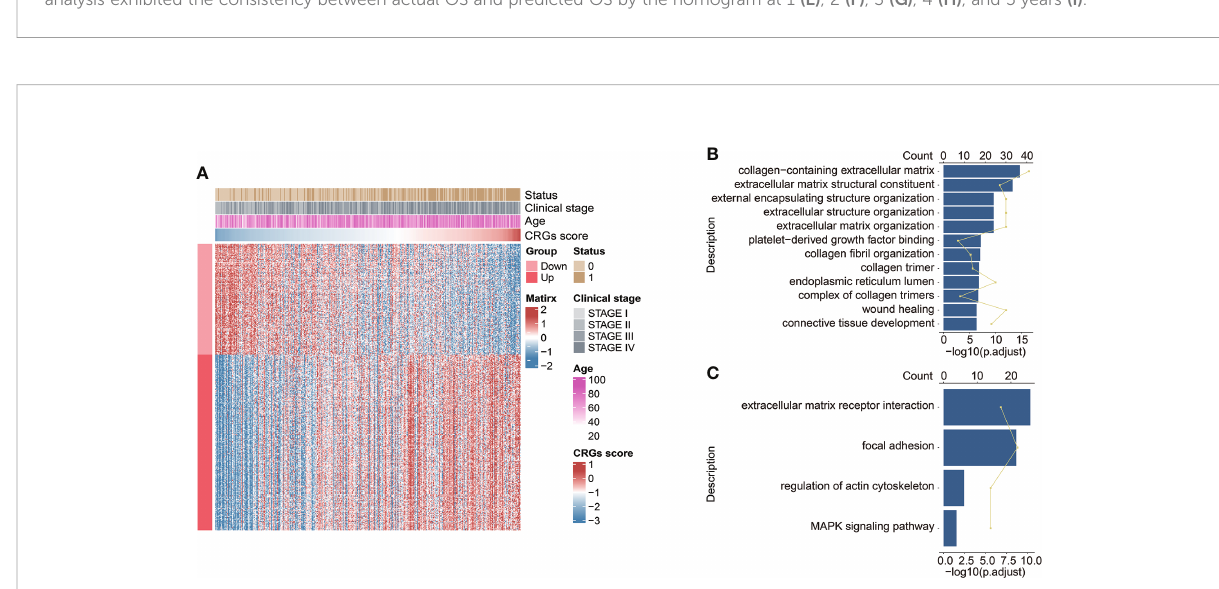
FIGURE 5 The construction of the CRG signature-based prognostic nomogram. The univariate (A) and multivariate (B) Cox regression analyses for the CRG signature and clinical features. (C) The constructed nomogram for the survival prediction of BC patients. (D) The receiver operating characteristic curve (ROC) analysis for evaluating the ability of novel constructed nomogram in prognosis prediction. The calibration curve analysis exhibited the consistency between actual OS and predicted OS by the nomogram at 1 (E) , 2 (F) , 3 (G) , 4 (H) , and 5 years (I) .